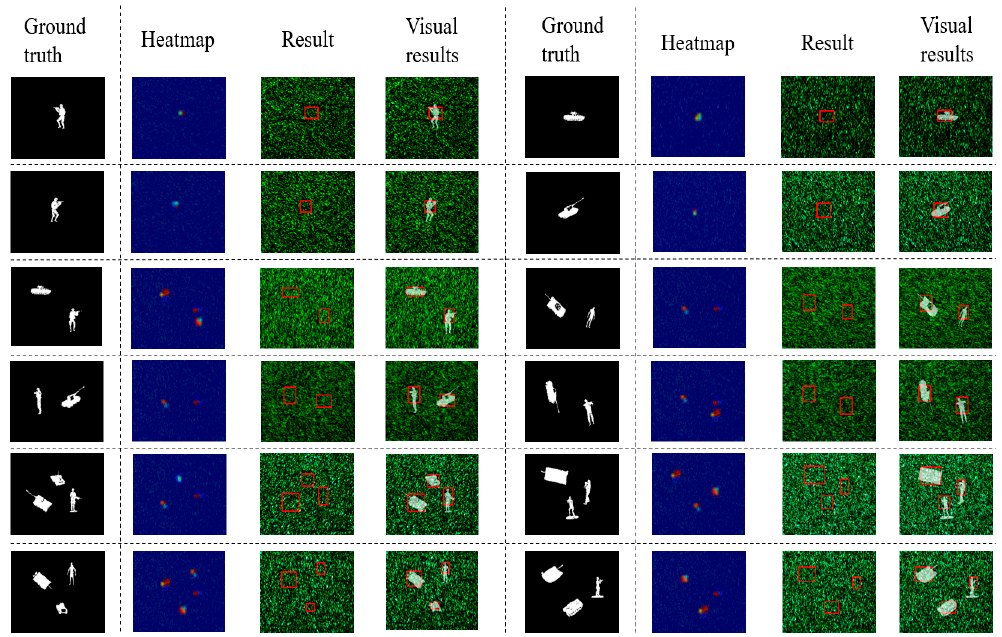
Figure 14. Position estimation results of the proposed method for a typical target. I have checked and revised all.